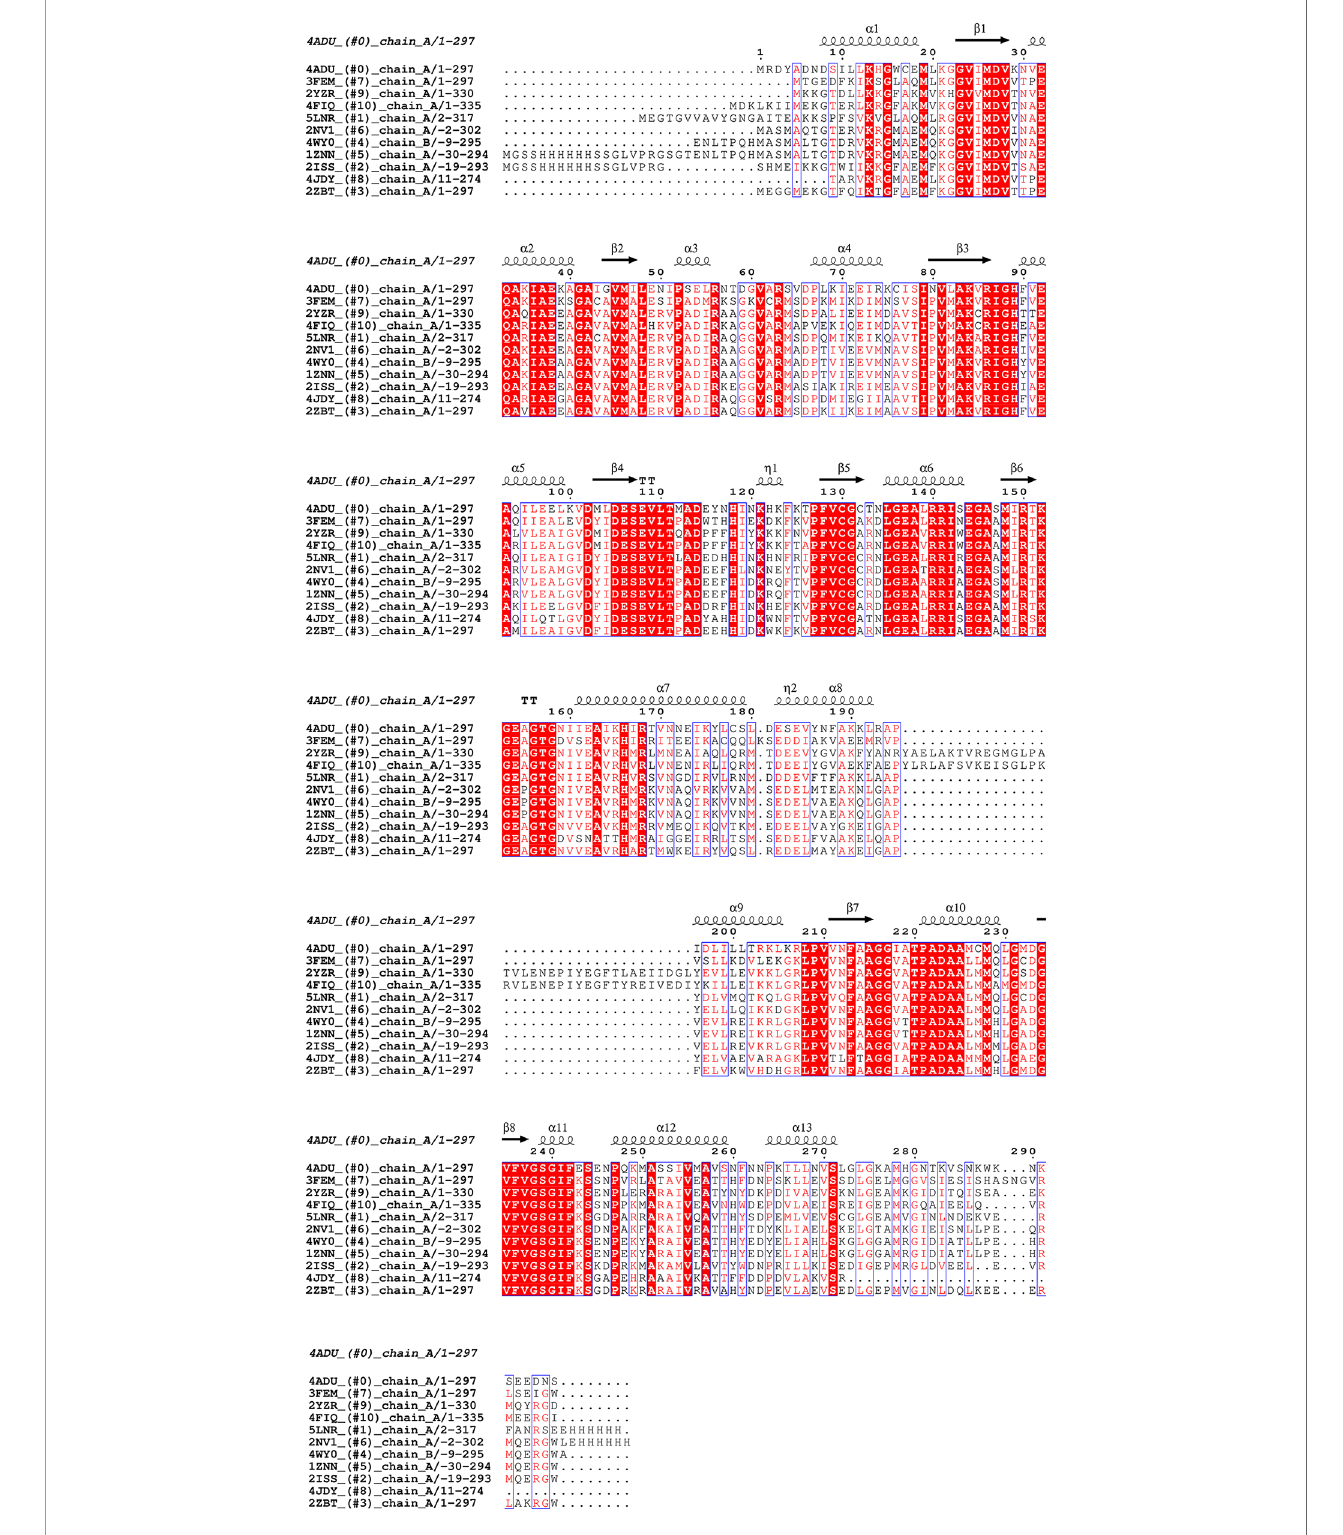
FIGURE 2 | Sequence alignment for Pdx1 enzymes. Alignment prepared with UCSF Chimera (Pettersen et al., 2004) and EPPript (Robert and Gouet, 2014).